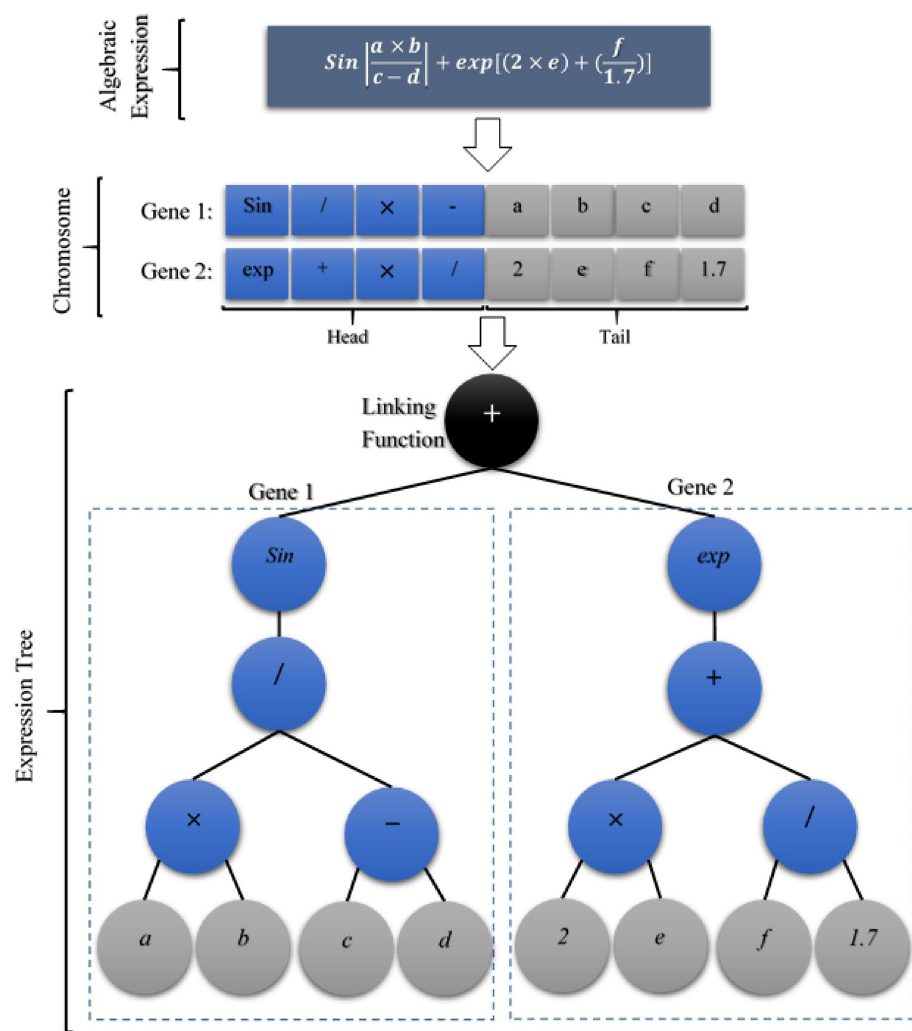
Fig. 1 A schematic representa- tion of the GEP structure